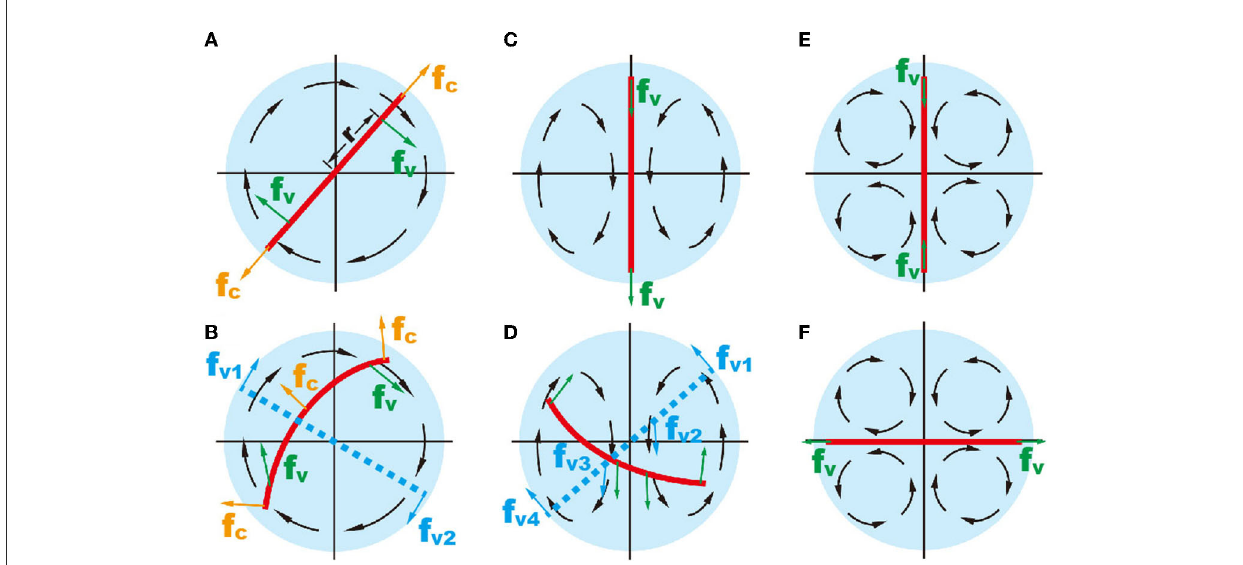
FIGURE2 Schematic showing the mechanical forces on an inextensible object (red line) in different flow patterns. (A, B) The object in one recirculating flow zone. (C, D) two recirculating flow; and (E, F) four recirculating flow. In (B, D) , the red solid lines represent a deformable object and the blue dashed lines represent an unbendable object.